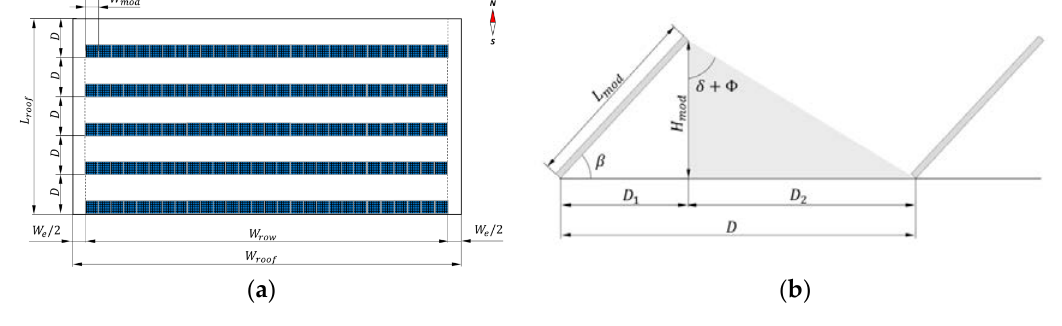
Figure 2. ( a ) PV field geometry; ( b ) PV rows shadows.